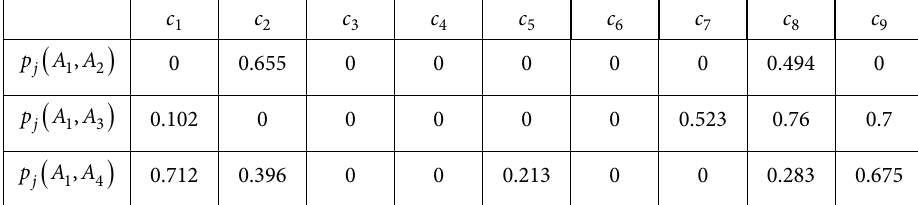
Table 4. Comprehensive preference relation among alternatives over each